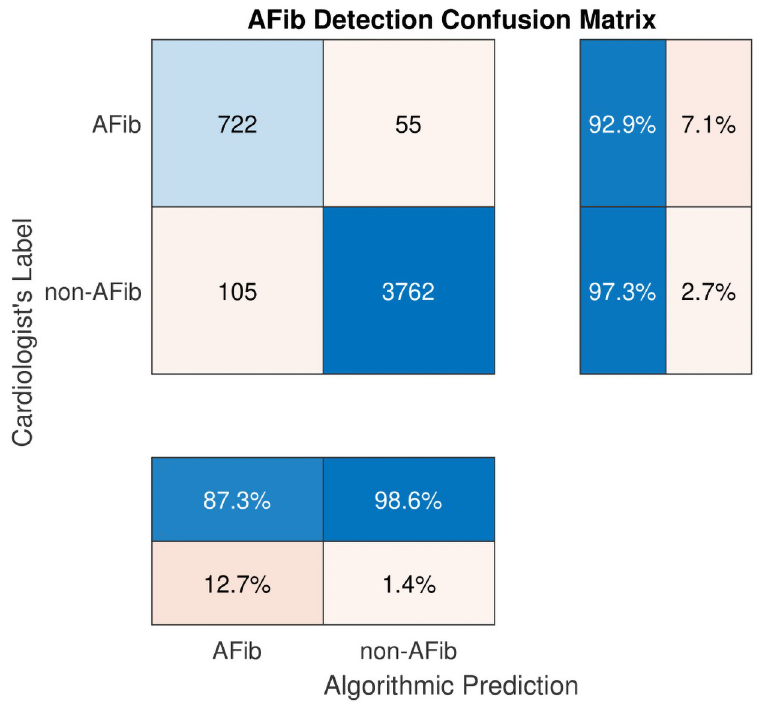
Fig 2. Confusion matrix for the proposed AFib detection algorithm.